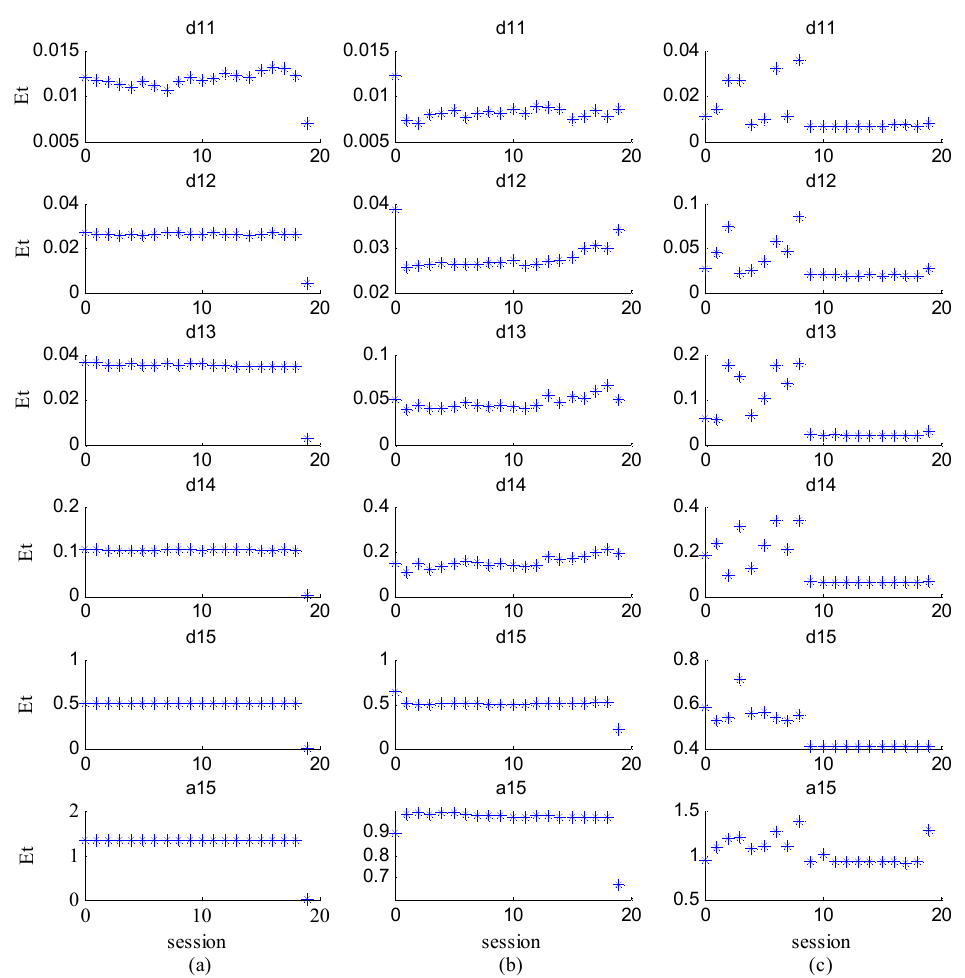
Figure 8. Et(i) energy distribution series of different overvoltage types. ( a ) Asymmetrical short circuit; ( b ) Power frequency resonance; ( c ) Harmonic resonance.